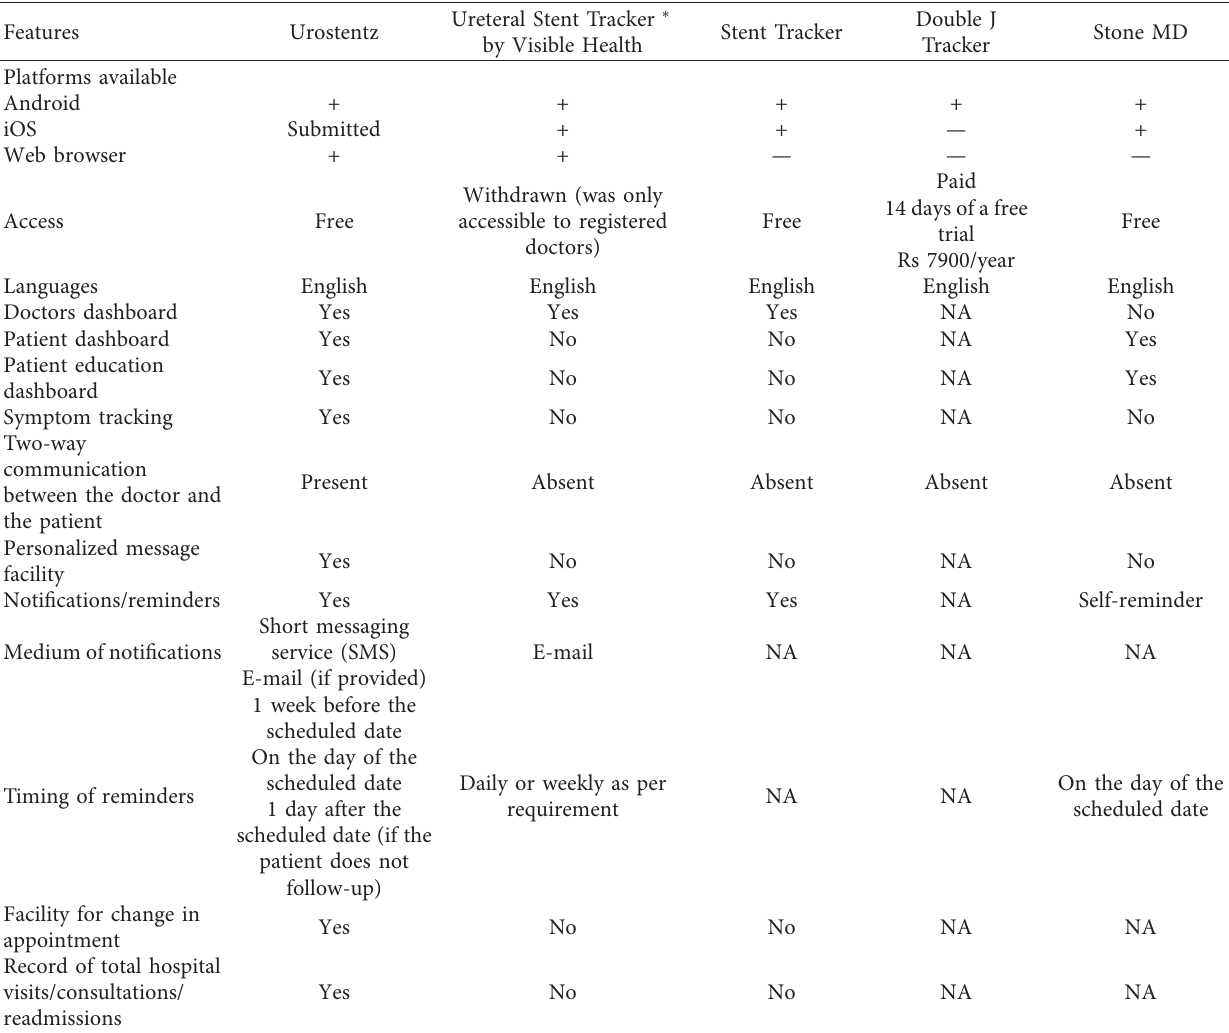
Table 2: Comparison of smartphone applications for ureteral stent